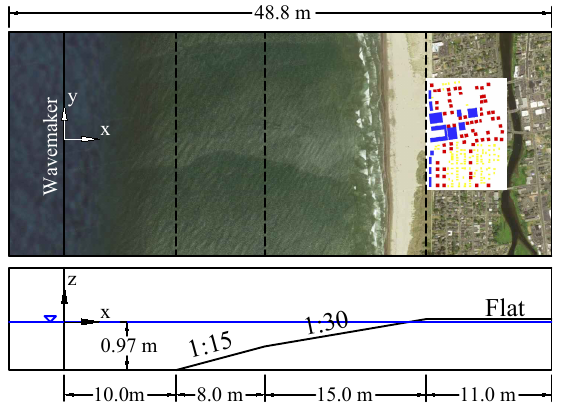
Figure 7. Four different subsections and layout of